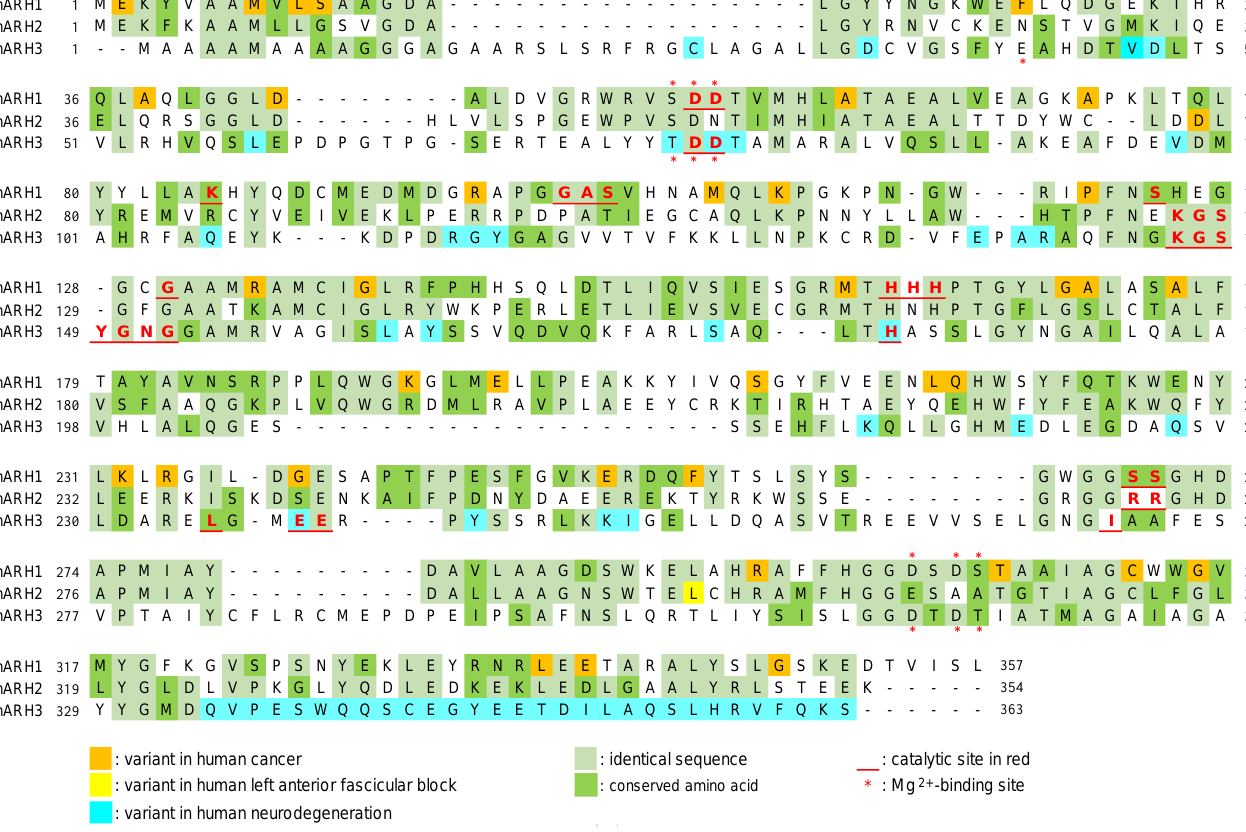
Figure 2. Modified figure of Oka et al. [59]. Alignment of amino acid sequences of human ARH1 (P54922), ARH2 (Q8NDY3), and ARH3 (Q9NX46). Sequence alignment was performed by T-Coffee method [59,101]. Mg 2+ -binding sites and critical amino acids for ARH1 [77,98,102], ARH2 [84], and ARH3 [24,99,100,103–105] activity were based on experiments and predictions. Variants in human cancer [77] , left anterior fascicular block [84] , and neurodegeneration [32–38] are based on previous reports and the Genome Aggregation Database